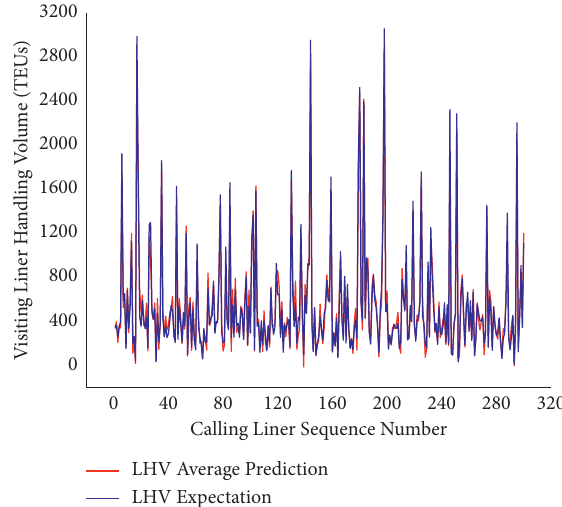
Figure 9: A comparison of LHV prediction average results with real values by LHV-IVE.